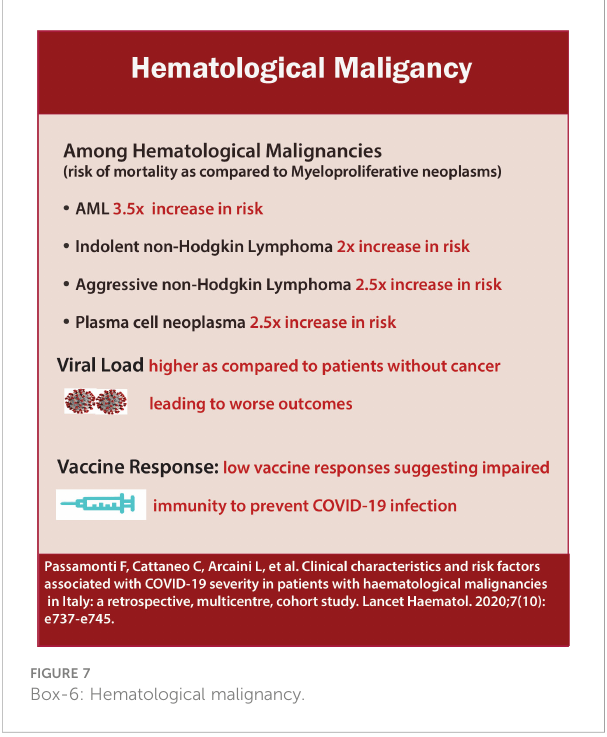
FIGURE 8 Box-7 Patients with Lymphoma and multiple myeloma at higher risk of severe COVID-19